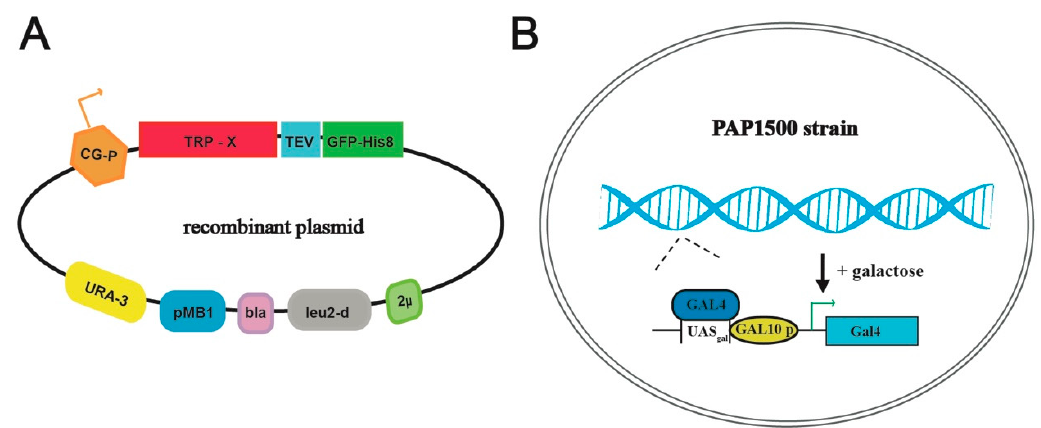
Figure 2. Schematic overview of the yeast production system. ( A ) Map of the employed plasmid encoding the respective TRP channels fused C-terminally with a Tobacco Etch Virus, TEV, protease cleavage site followed by green fluorescent protein sequence, GFP, attached to an octa-histidine stretch, His8-tag (TEV-GFP-His8-tag). Other critical elements of the plasmid include 2 µ (yeast 2 micron origin of replication), leu2-d (poorly expressed allele of the β -iso-propyl-malate dehydrogenase gene), bla ( β -lactamase gene), pMB1 (pMB1origin of replication), URA3 (yeast orotidine-5’-phosphate decarboxylase gene) and CG-P (hybrid promoter of GAL10 upstream activating sequence and 5’ non-translated leader of cytochrome-1 gene). ( B ) The Saccharomyces cerevisiae protein production strain PAP1500 overexpresses the Gal4 transcriptional activator in the presence of galactose. Gal4 is the limiting factor for expression from galactose regulated promoter. GAL10 p, UASgal, a specific DNA binding site for GAL4 activator.